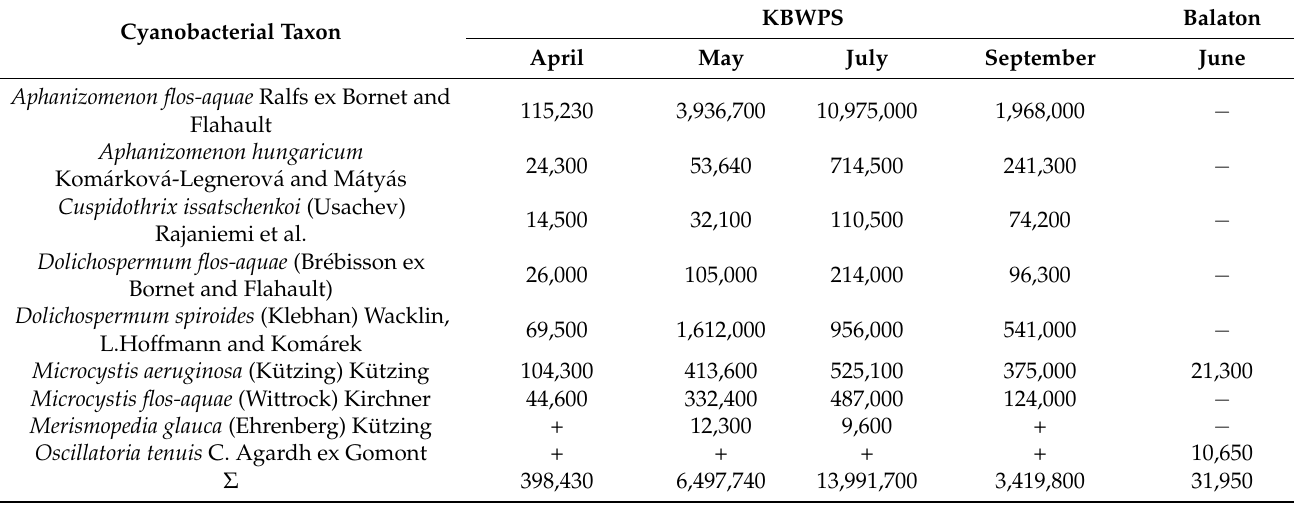
Table 4. Qualitative and quantitative composition of the cyanobacterial community of the Kis-Balaton Water Protection System (KBWPS) and Lake Balaton during the investigated period of